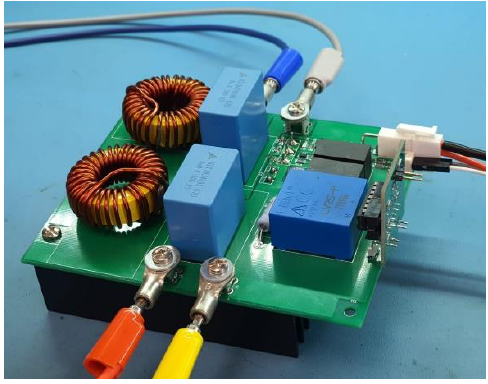
Figure 31. Prototype photo.